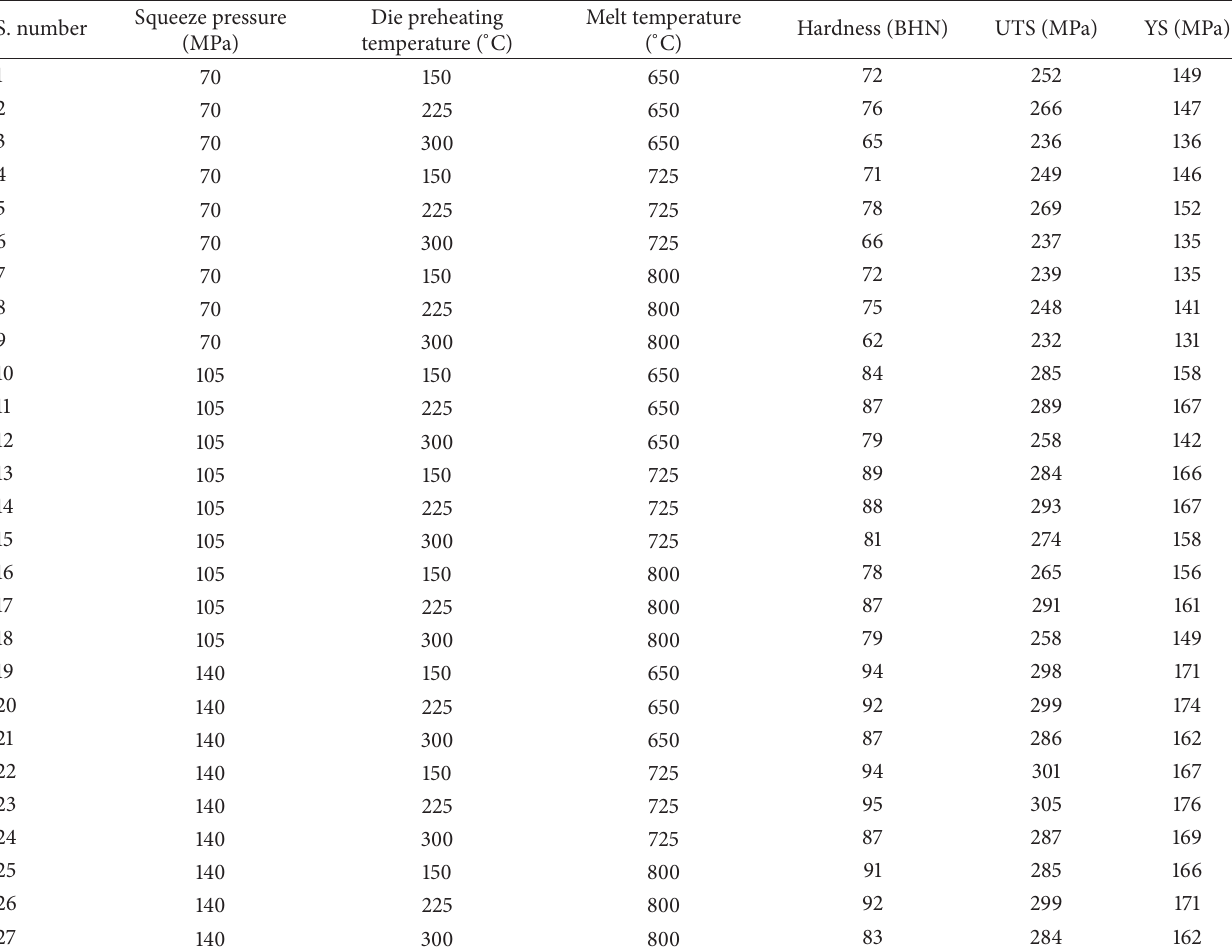
Table 4: Assigned orthogonal L27 with the acquired data.